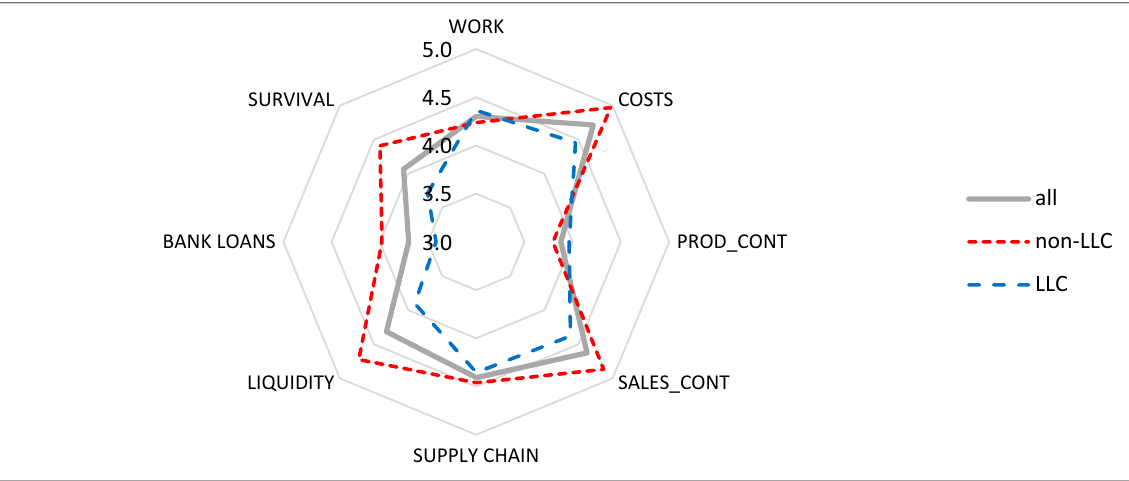
Figure 4. Perception of the COVID-19 interruptions and business organization form (OWN_1).